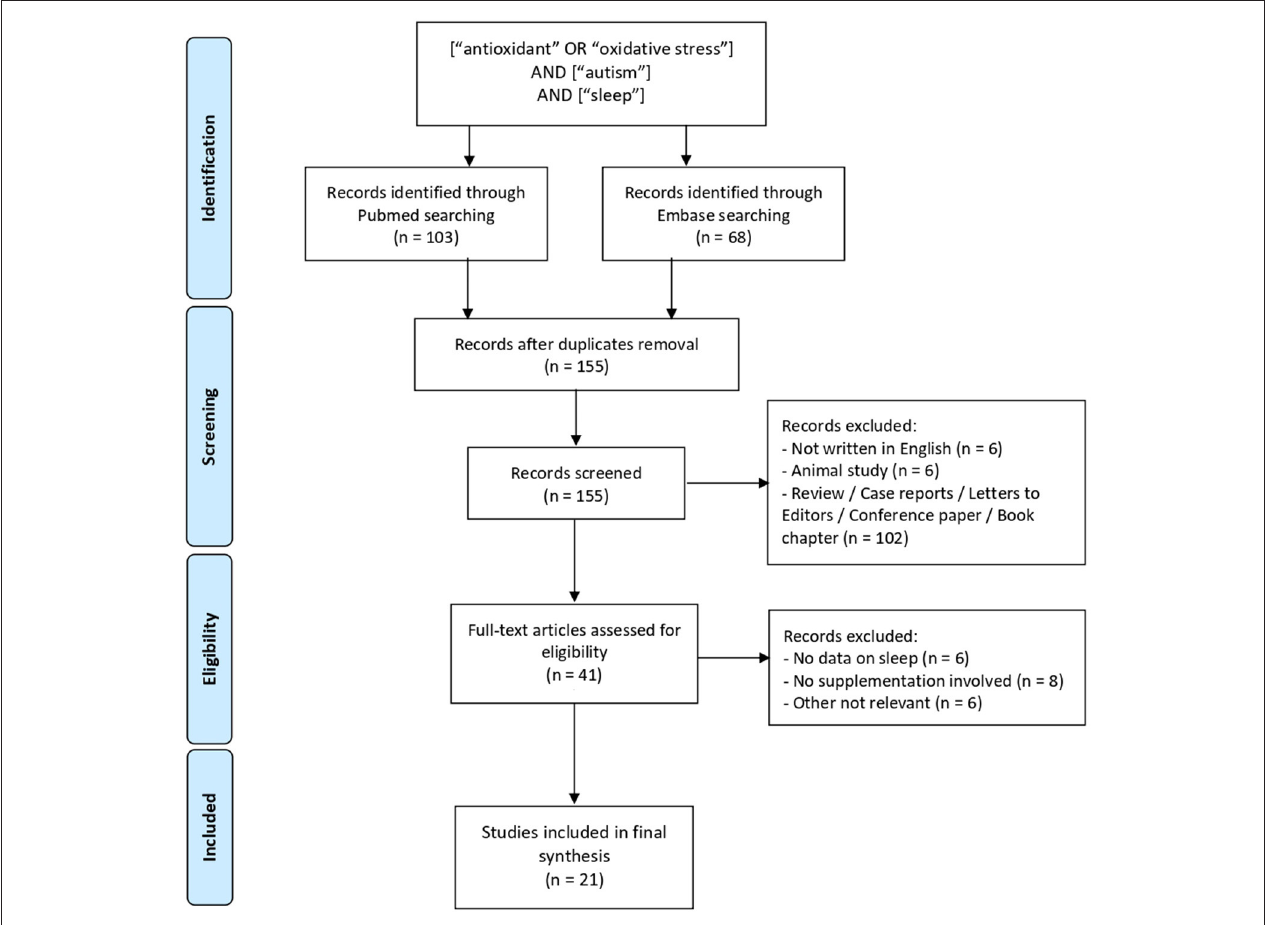
FIGURE 1 | Preferred reporting items for systematic reviews and meta-analyses (PRISMA) flow diagram of literature review and study